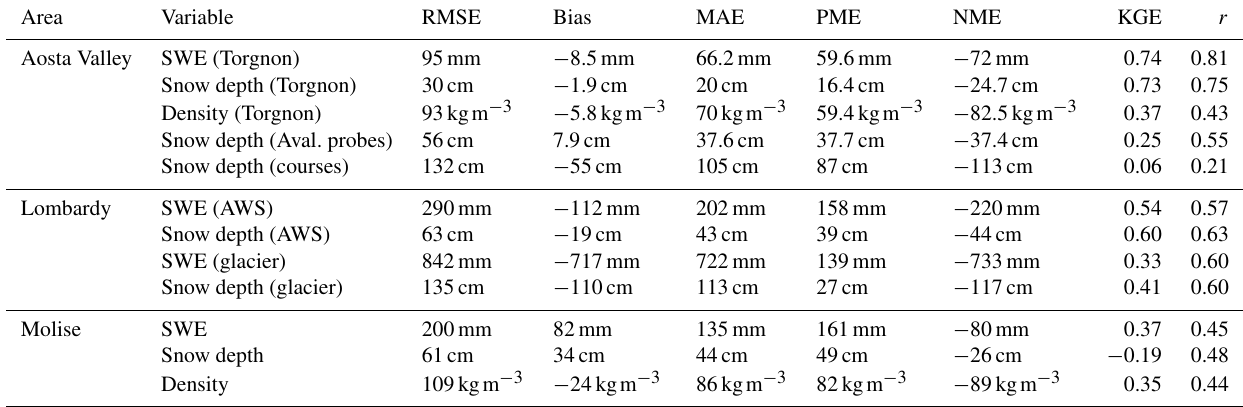
Table 1. Overview of IT-SNOW performance versus in situ data in Aosta Valley, Lombardy, and Molise. RMSE is the root mean square error, MAE is the mean absolute error, PME is the positive mean error, NME is the negative mean error, KGE is the Kling–Gupta efficiency (Kling et al., 2012), and r is Pearson’s correlation coefficient.